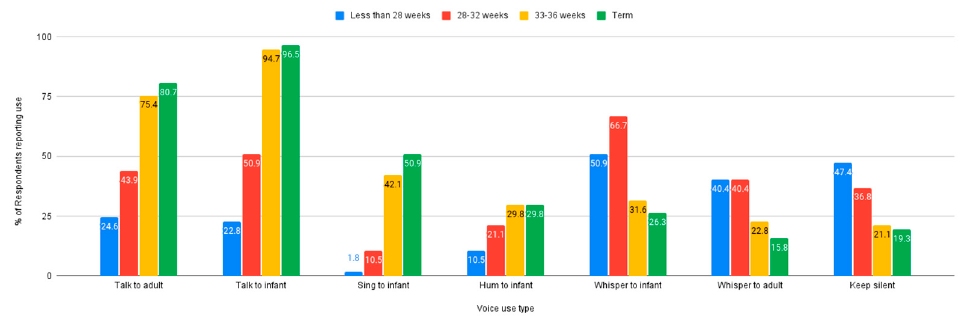
Figure 1. Type of voice use reported by infant gestational age